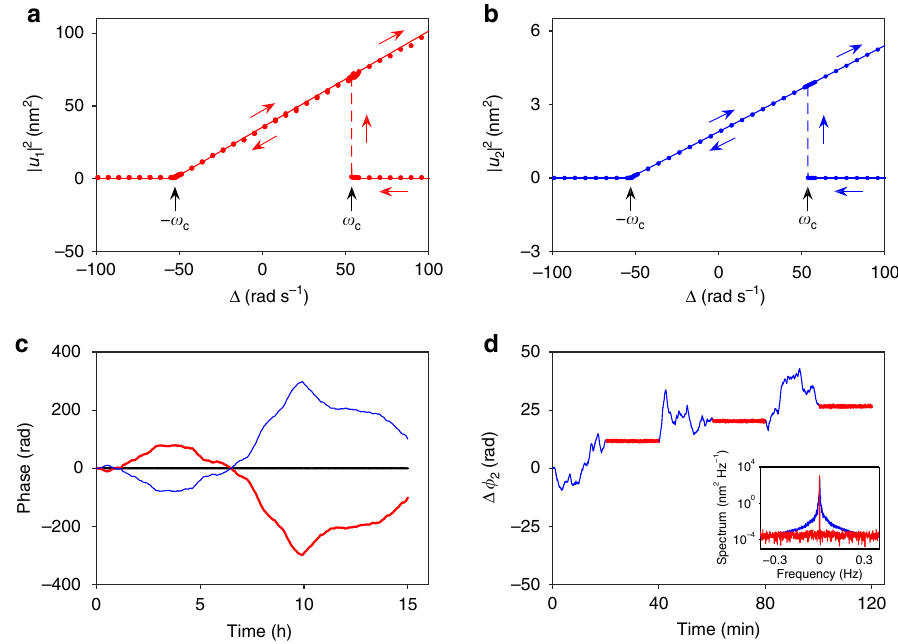
Figure 3 | Hysteresis of self-sustained vibration amplitude and correlated phase fluctuations of the two modes. ( a ) Square of the amplitude of self-sustained vibrations of the plate mode as a function of pump detuning D . The error bar is smaller than the dot size. ( b ) The same plot for the beam mode. The solid lines are theoretical predictions using equation (2). The slopes involve no adjustable parameters. ( c ) Phase change for the plate D f 1 ( t ) (red) and the beam mode D f 2 ( t ) (blue). The black line shows D f 1 ( t ) þ D f 2 ( t ). The error bar is smaller than the line thickness. ( d ) Change in phase of the beam mode as a function of time. The feedback is turned on (off) for the red (blue) data. Inset: spectra of the self-sustained vibrations of the